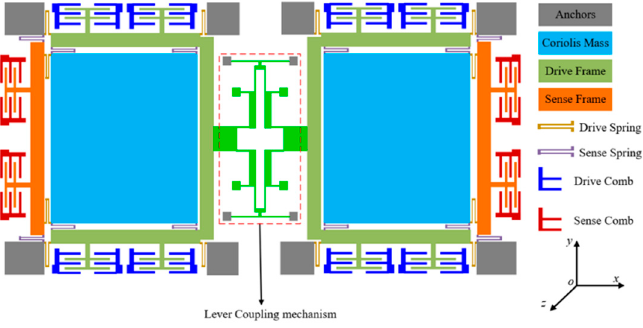
Figure 10. A shock-resistant dual-mass gyroscope [94]